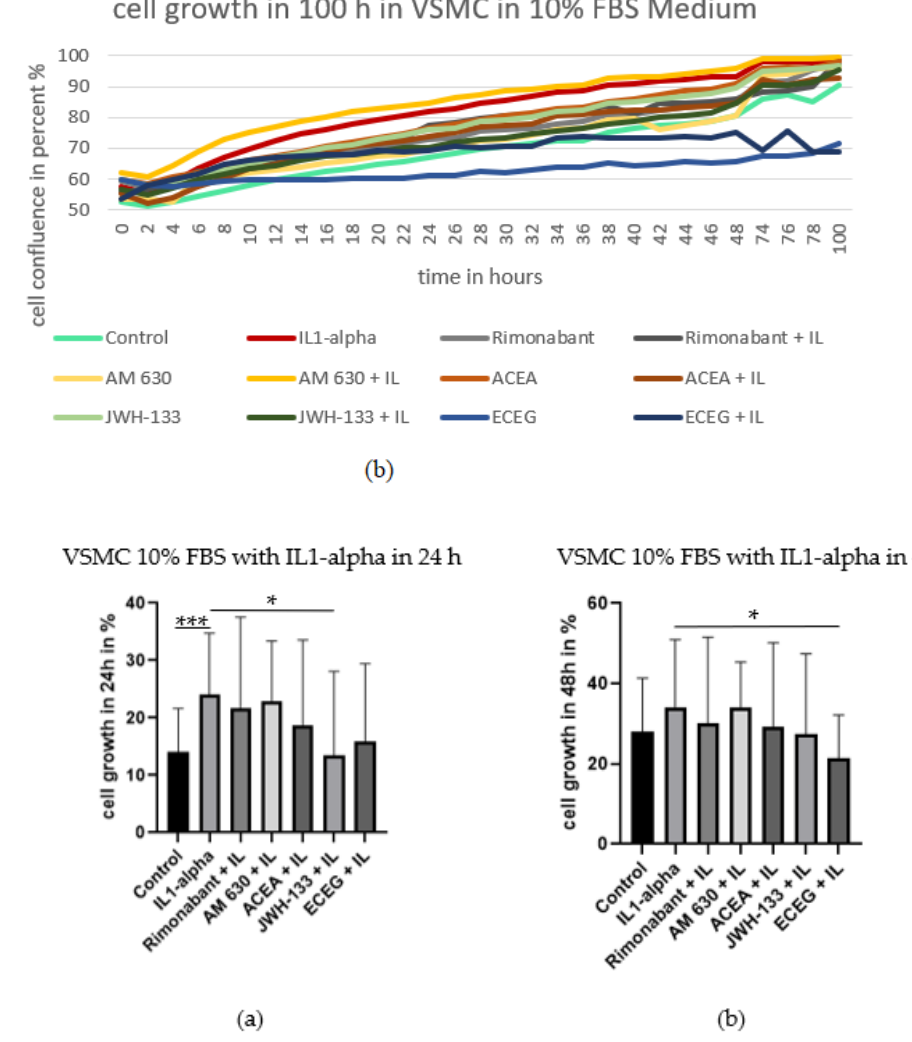
Figure 5. ( A ) ( a ) VSMC, cell confluence difference (cell growth) at 24 h (confluence at 24 h-confluence at 0 h) and the confluence at 48 h (confluence at 48 h-confluence at 0 h) in the treatment groups. The experiment was performed using 10% FBS medium with and without IL-1 α stimulation in all treatment groups. ( b ) VSMC, cell growth in dynamic. Representative graph obtained from IncuCyte Live-Cell Analysis System. Cell proliferation was monitored by analyzing the occupied area (% confluence) of cell images over 100 h. Analysis of the IncuCyte images was performed with Incucyte ® Analysis Software. The experiment was performed using 10% FBS medium with and without IL-1 α stimulation in all treatment groups. ( B ) The growth rate (confluence difference) of VSMCs estimated by IncuCyte live-cell analysis after treatment with compounds after IL-1 α stimulation in 24 h ( a ) and 48 h ( b ). Statistical testing was performed using unpaired t-tests. Significance was expressed when p < 0.05; n = 6–32 (* p < 0.05; *** p <